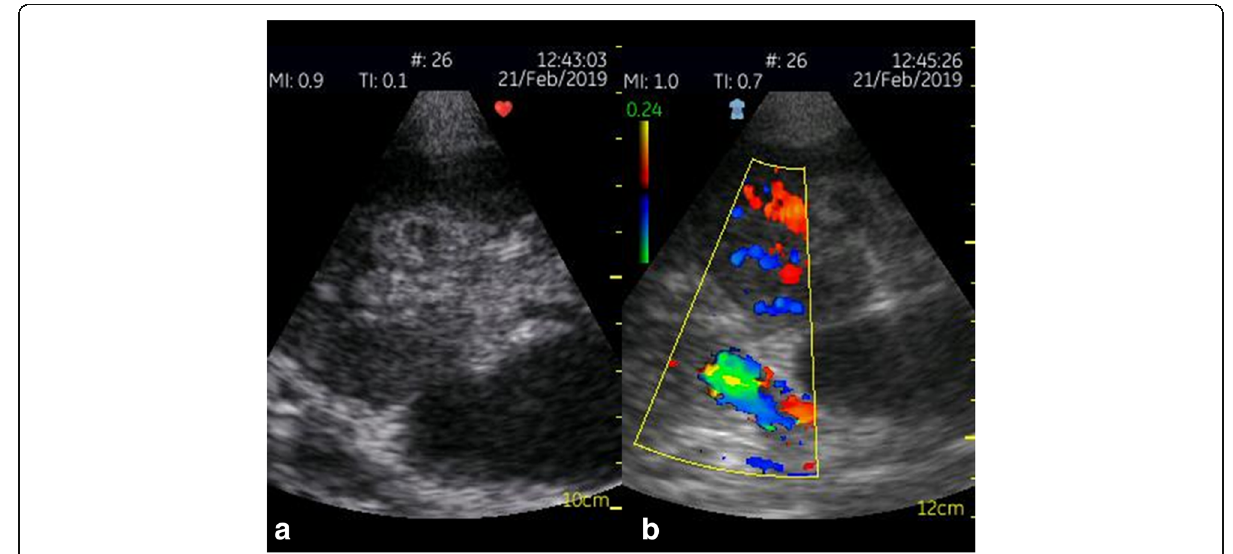
Fig. 5 GE Healthcare VScan (phased array transducer): B-scan ultrasound ( a ) and colour Doppler ( b ) of a transplant